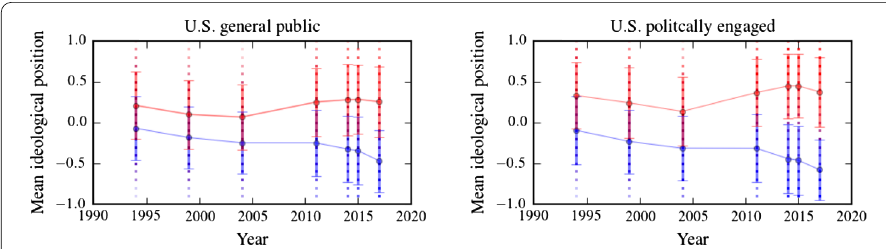
Figure 1 Polarization in the U.S. public. We show the mean-ideological position (i.e., the mean of the ideology distributions provided in [6]) of the Democratic- (blue) and Republican-leaning (red) segments of U.S. public from 1994 to 2017. Error bars indicate the observed standard deviation in each year. It is evident that polarization has been increasing in the past 15 years. The plotted data are based on a survey conducted by Pew Research Center (see [6] for